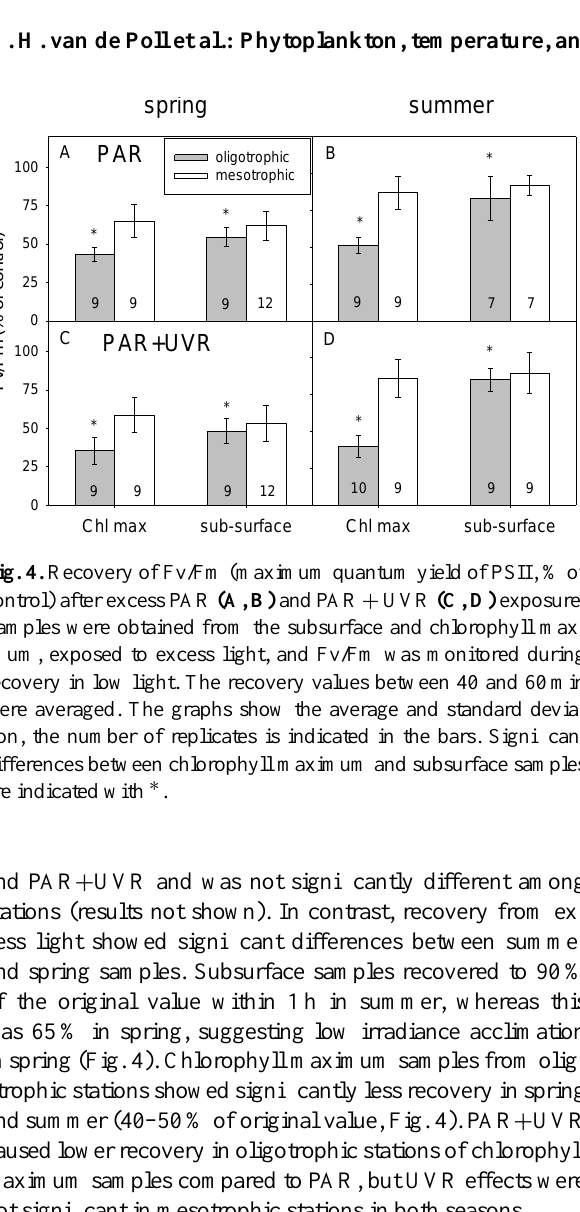
Fig. 4. Recovery of Fv/Fm (maximum quantum yield of PSII, % of control) after excess PAR (A, B) and PAR+UVR (C, D) exposure. Samples were obtained from the sub-surface and chlorophyll maximum, exposed to excess light and Fv/Fm was monitored during recovery in low light. The recovery values between 40 and 60 min were averaged. The graphs show the average and standard deviation, the number of replicates is indicated in the bars. Significant differences between chlorophyll maximum and sub-surface samples are indicated with *.